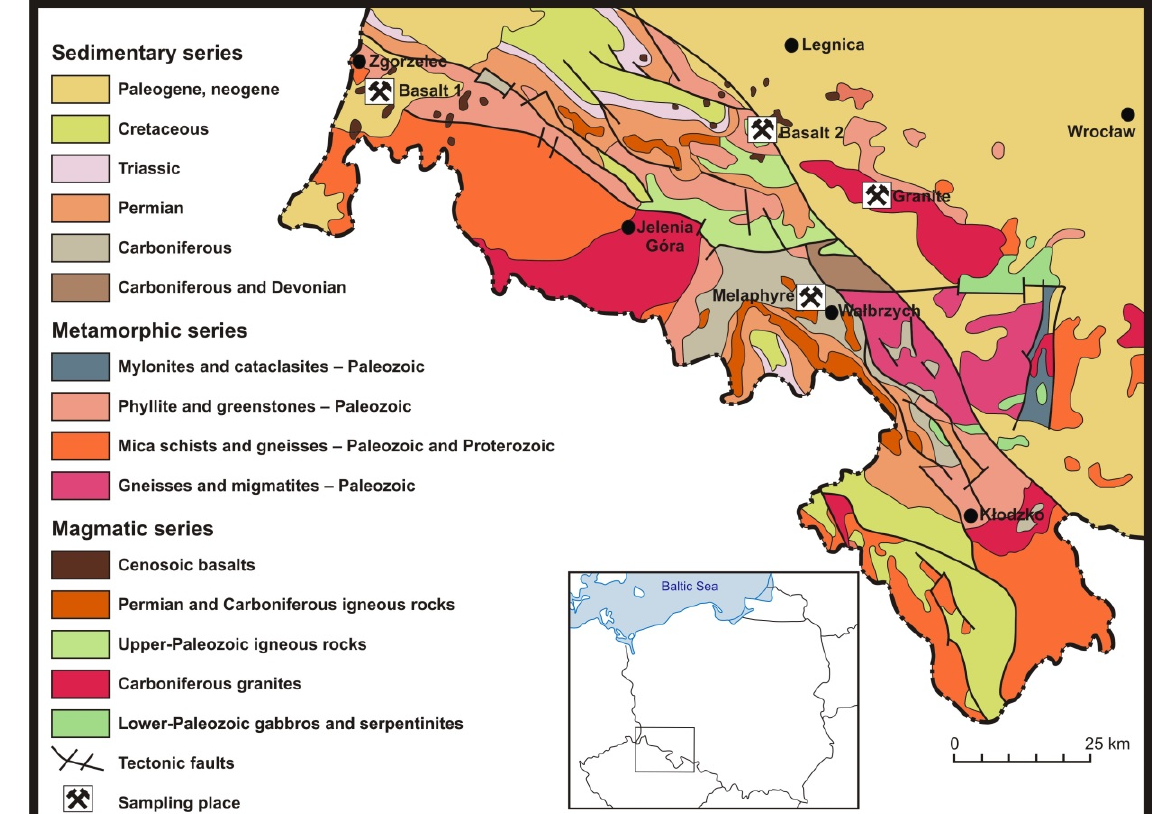
Figure 1. Locations in which the specimens were collected, shown on the geological map of the Lower Silesia region (own work based on [48]).